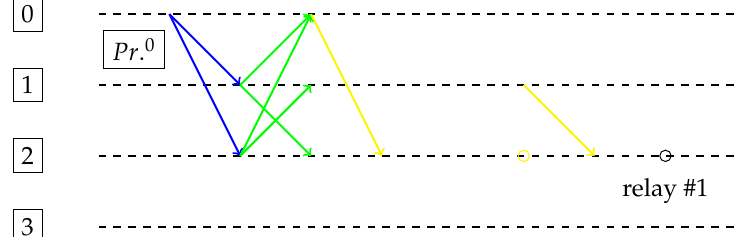
Figure 2. Scenario P 6 with N = 4 and t max = 10 (block is quickly generated). Messages are so much minimized that speaker does not waste its commit (just marked as an empty circle), avoiding the computation of an extra message to be delivered.